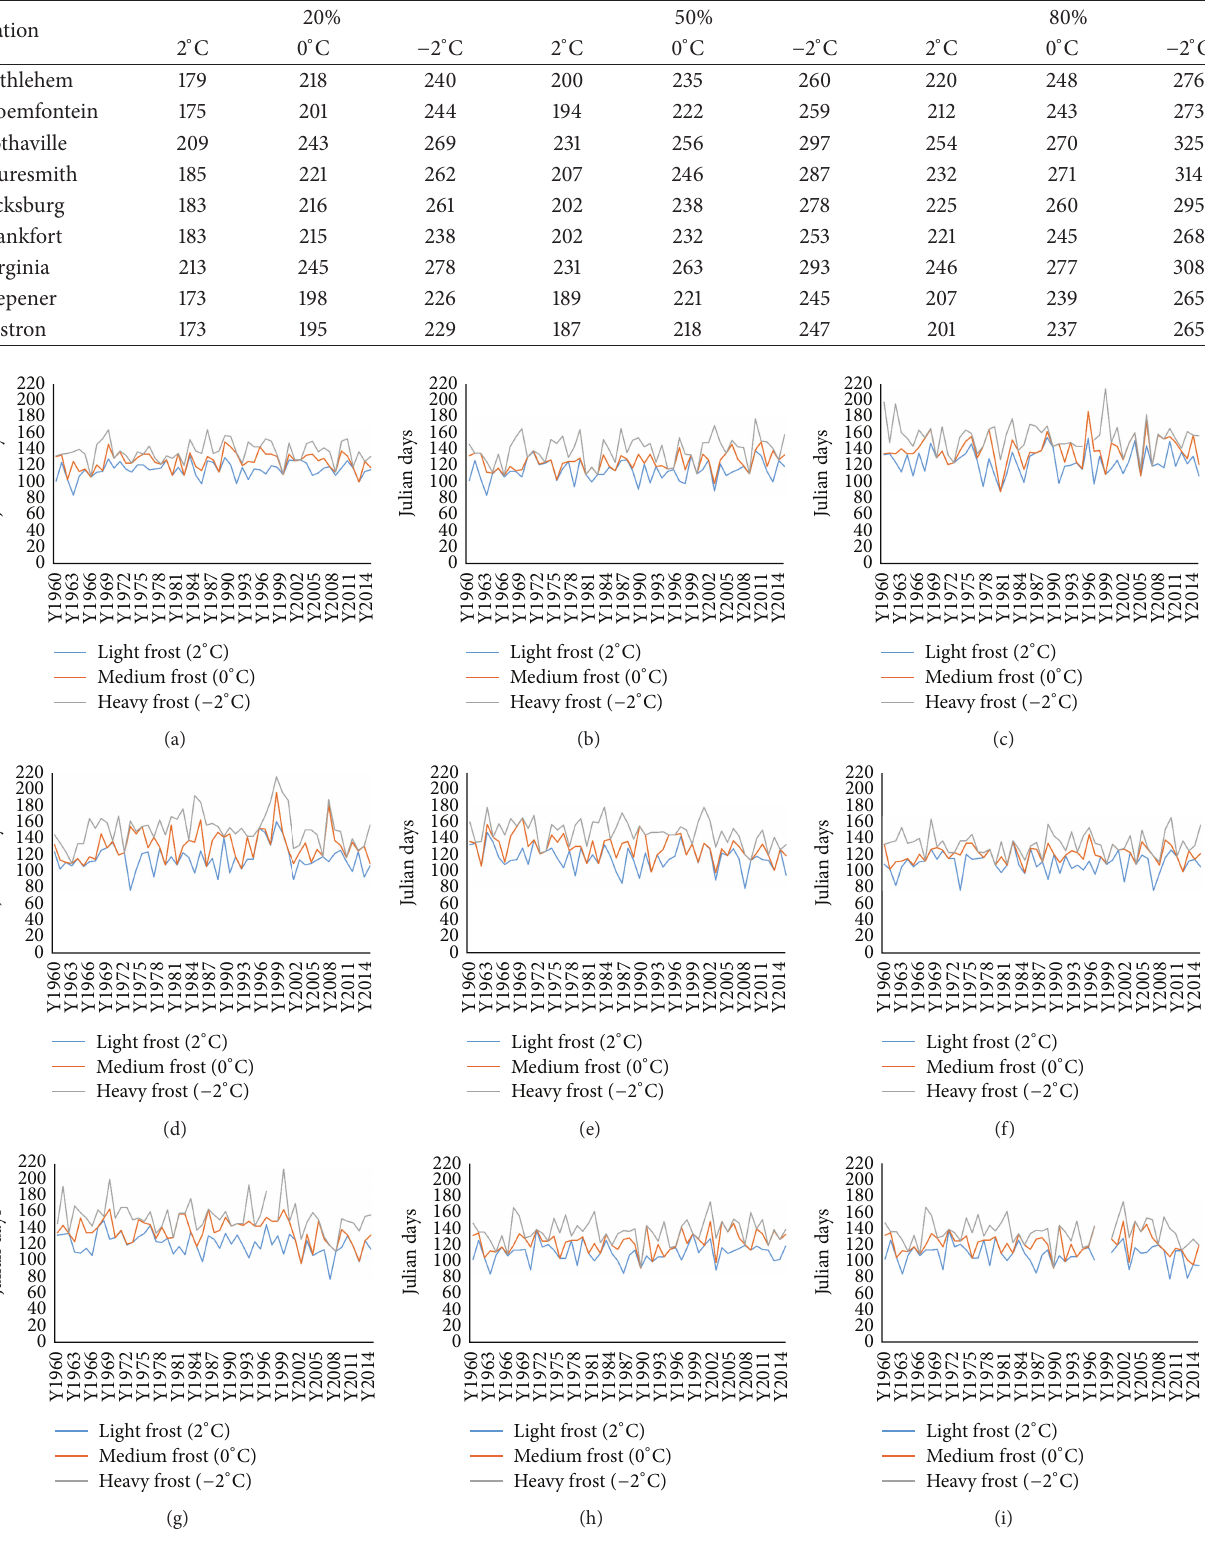
Figure 4: Time series of onset of frost in Julian days from 1960 to 2014 for (a) Bethlehem, (b) Bloemfontein, (c) Bothaville, (d) Fauresmith, (e) Ficksburg, (f) Frankfort, (g) Virginia, (h) Wepener, and (i)